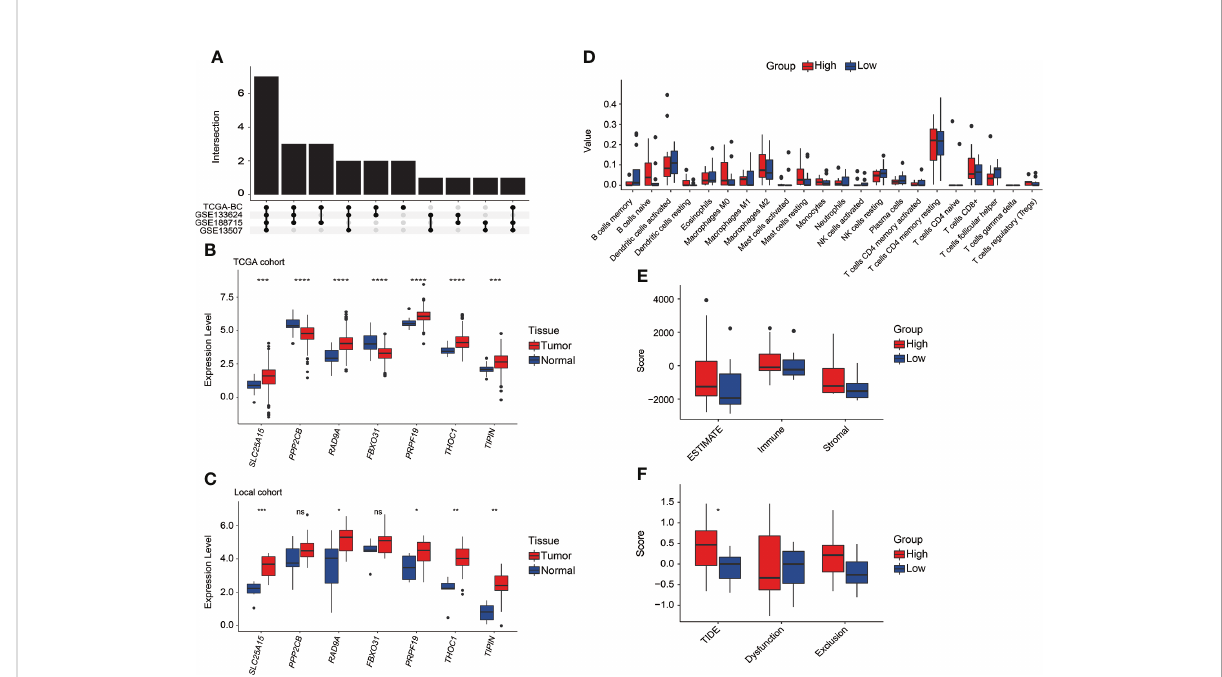
FIGURE 9 The exploration of the CRG signature and related genes in the local BC cohort. (A) Overlapping number of differentially expressed CRGs between tumor and normal tissue samples across the TCGA, GSE133624, GSE188715, and GSE13507 cohorts. (B) The comparison of seven CRG signature-related genes ’ expression between tumor and normal tissue samples in the TCGA cohort. (C) The comparison of seven CRG signature-related genes ’ expression between tumor and normal tissue samples in our local cohort. (D) The evaluation of 22 tumor-in fi ltrated lymphocytes between high-risk and low-risk groups in our local cohort. (E) Comparison of stromal, immune, and ESTIMATE scores between high-risk and low-risk groups in our local cohort. (F) Comparison of T-cell dysfunction, exclusion, and TIDE scores between high-risk and low- risk groups in our local cohort. *p < 0.05, **p < 0.01, ***p < 0.001, ****p < 0.0001, ns represented “ not signi fi cant ”